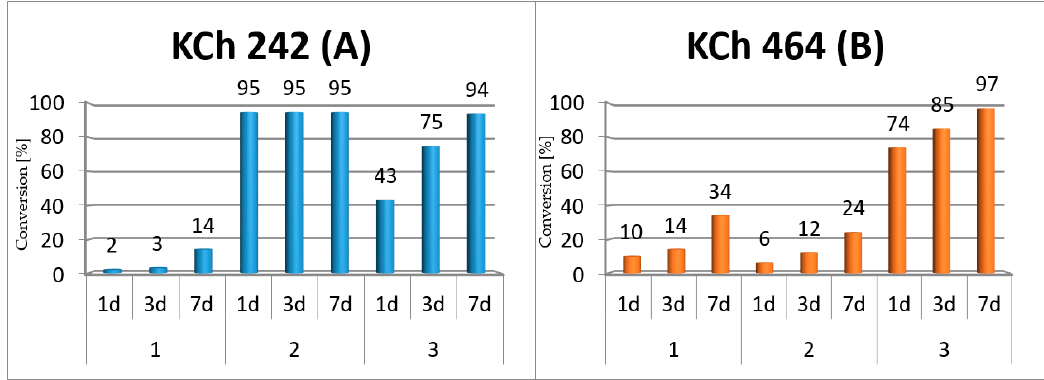
Figure 1. ( A ) Substrate conversionby R. glutinis KCh 242 strain after 1 and 7 days of incubation. ( 1 ) 2 ′ -hydroxy-2 ″ -methoxychalcone, ( 2 ) 2 ′ -hydroxy-3 ″ -methoxychalcone and ( 3 ) 2 ′ -hydroxy-4 ″ - methoxychalcone; ( B ) Substrate conversionby S. Cerevisiae KCh 464 strain after 1 and 7 days of incubation. ( 1 ) 2 ′ -hydroxy-2 ″ -methoxychalcone, ( 2 ) 2 ′ -hydroxy-3 ″ -methoxychalcone and ( 3 ) 2 ′ -hydroxy-4 ″ -methoxychalcone. Table 3. Conversion of selected substrates depending on their concentration and biotransformation time, performed in triplicate.